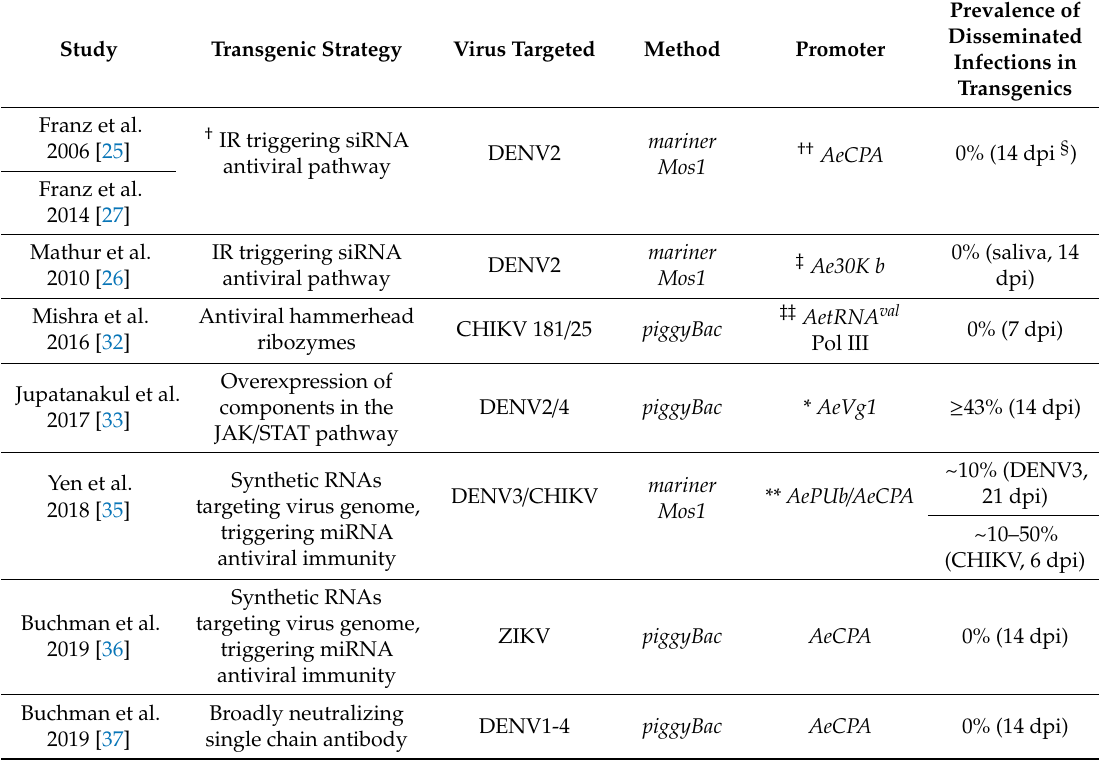
Table 1. Transgenic Ae. aegypti engineered (to date) to be resistant to arbovirus infections.